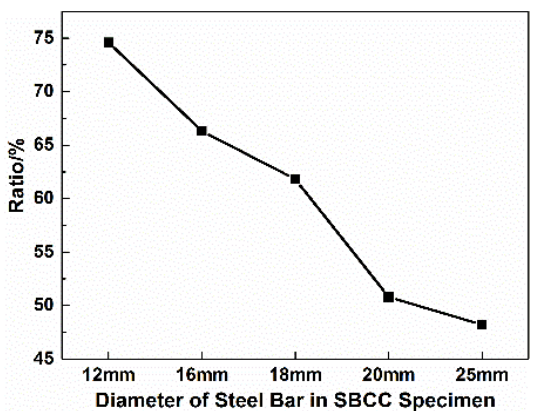
Figure 14. The ratio of the tensile force corresponding to the peak value on the first derivative curve of the By signal to the yield tension, with SBCC specimens of di ff erent steel bar diameters during the elastic stage in the fixed-point monitoring